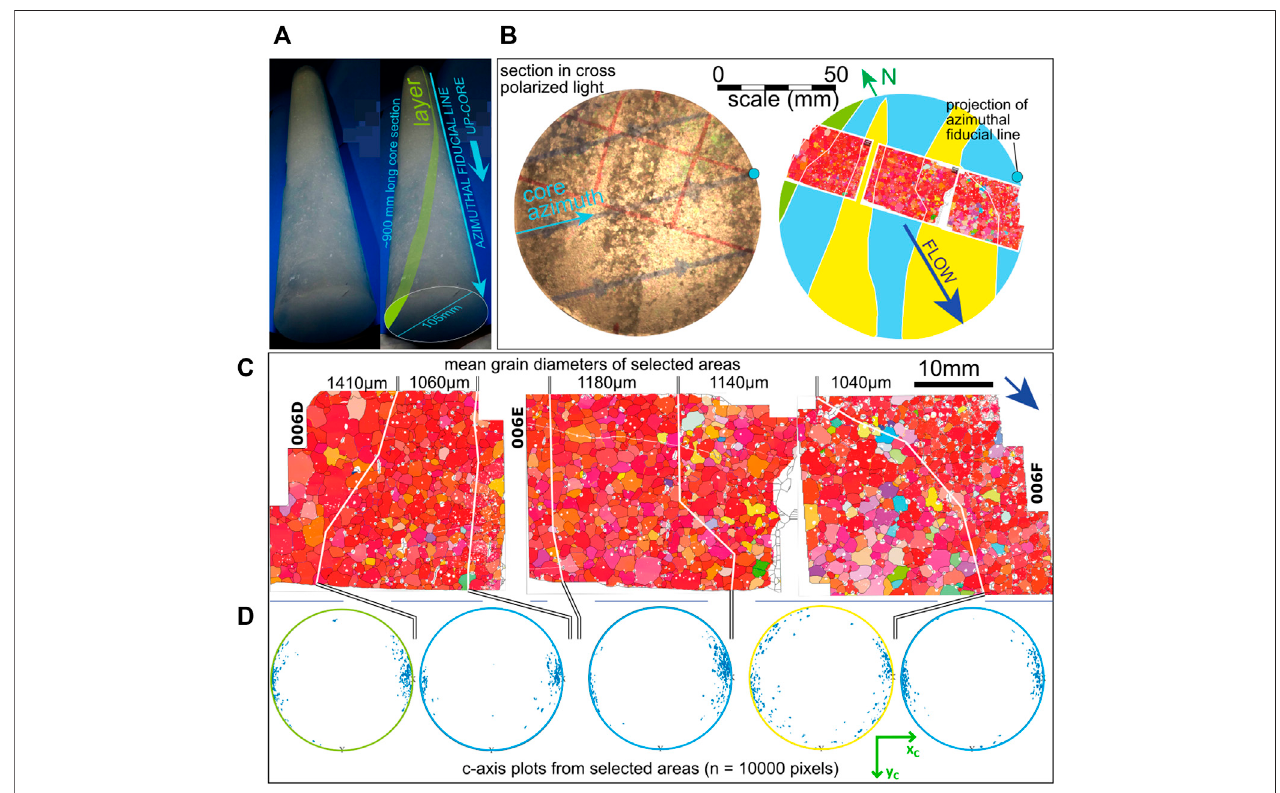
FIGURE9| Microstructuralvariationsrelated todifferentlayersincore. (A) Photograph(markedofcoresection 6(4.4 – 5.3 mdepth)withacurviplanar,sub-vertical layer of clear ice, annotated in green on right hand layer. This layer corresponds to an indistinct trace in the televiewer image ( Figure 3A ). (B) Transmitted light image in crosspolarsandinterpretivesketchthrougha5 mmthickicesectiontakenfromthecoreendshowninA.EBSDmapsaresuperposedtoshowlocationrelativetolayers. ThelayershadedgreencorrespondstothelayerofcleariceshowninA.Theotherlayers(shadedyellowandblue)arevisibleincorebutmuchlessdistinct.Theyare sub-paralleltotheclearicelayer.Sectionsareorientedinthe c -axismaximumreferenceframe(explainedbelow).Ice fl owdirectionandgeographicnortharemarked. (C) EBSDmapsacrossthelayers,rotatedanti-clockwisefromB.Foreaseofdisplay:arrowshowsice fl owdirection.Meangraindiametersforselectedareascorresponding tothelayersareshown.ColorschemeforallmapsisIPFforthe “ c -axismaximum ” referenceframe(see Figure6 ),angleofrotationdetermined fromtheleft(006D)map. Grains with c -axis the same as the statistical maximum are red (see IPF key in Figures 6 , 8 ). (D) Stereonets showing the c -axis orientations ( n (cid:2) 10,000 pixels) for ice grains in selected areas corresponding to the